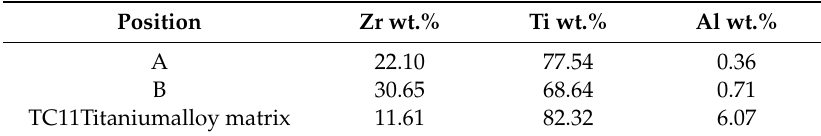
Table 1. Electron probe micro-analyzer (EPMA) analysis of di ff erent position components of the coating of